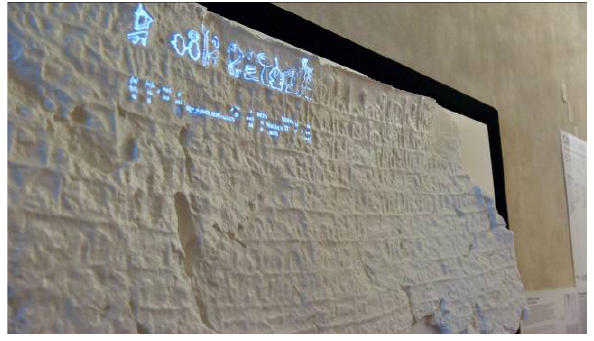
Figure 13. 3D video